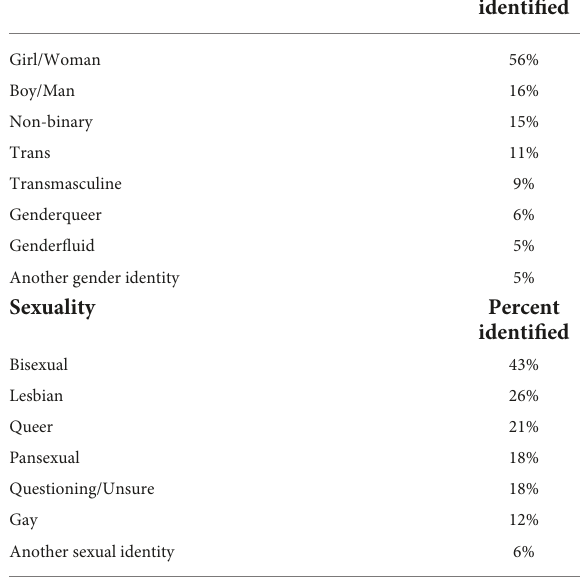
TABLE 1 Canadian students’ gender and sexual identities.